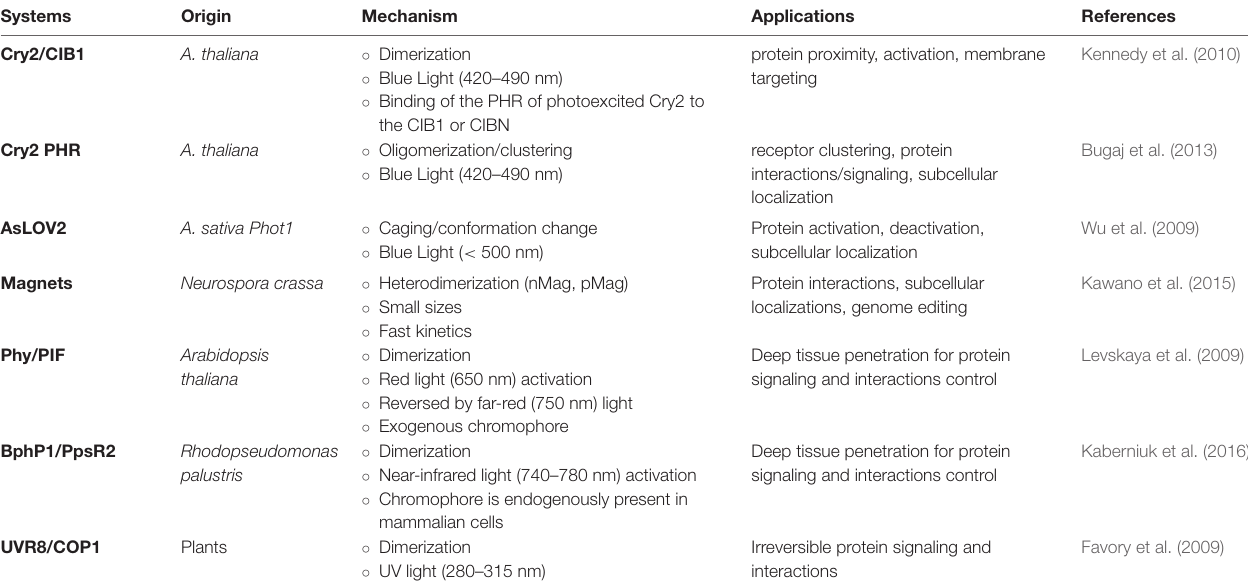
TABLE 1 | Summary of common optogenetic systems, mechanisms, and applications.